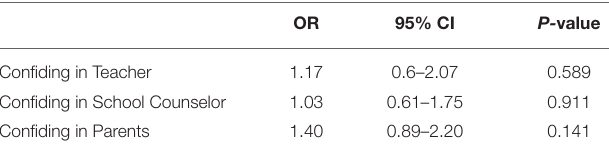
TABLE 3 | Odds ratios for finding confiding in someone beneficial among students who reported self-harm thoughts. OR 95% CI P- value Confiding in Teacher 1.17 0.6–2.07